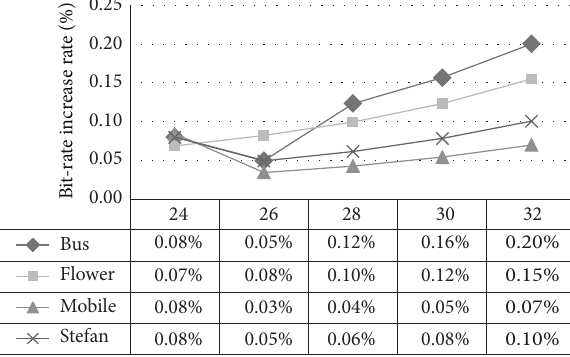
Figure 21: Bit-rate increase rate for different sequences and